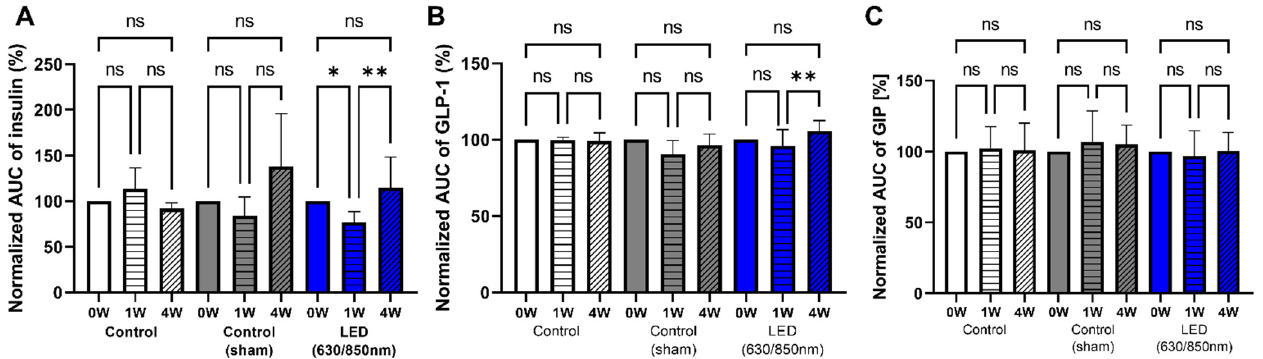
Figure 6. Effects of duodenal dual-wavelength (D) photobiomodulation (PBM) with light-emitting diode (LED) on the production of insulin, glucagon-like peptide 1 (GLP-1), and glucose-dependent insulinotropic polypeptide (GIP) at the baseline and 1 and 4 weeks after the procedure. Serum concentrations of insulin, GLP-1, and GIP were measured using ELISA (Control n = 5, sham n = 5, and dual-wavelength as 630/850 nm, n = 7). Values are expressed as mean ± SEM. Area under the curve (AUC) during a 120-min oral glucose tolerance test at baseline (0 weeks), after 1 week, and after 4 weeks. ( A ) Insulin-AUC was significantly increased in the sham control and duodenal dual-wavelength photobiomodulation (D-PBM) (630/850 nm) groups between 0 versus 1 week ( p < 0.05) and 1 versus 4 weeks ( p < 0.01). ( B ) Differences in GLP-1 significantly increased ( p < 0.01) in the D-PBM group (630/850 nm) between 1 and 4 weeks. ( C ) GIP serum levels showed no differences among the groups. * p < 0.05; ** p < 0.01.